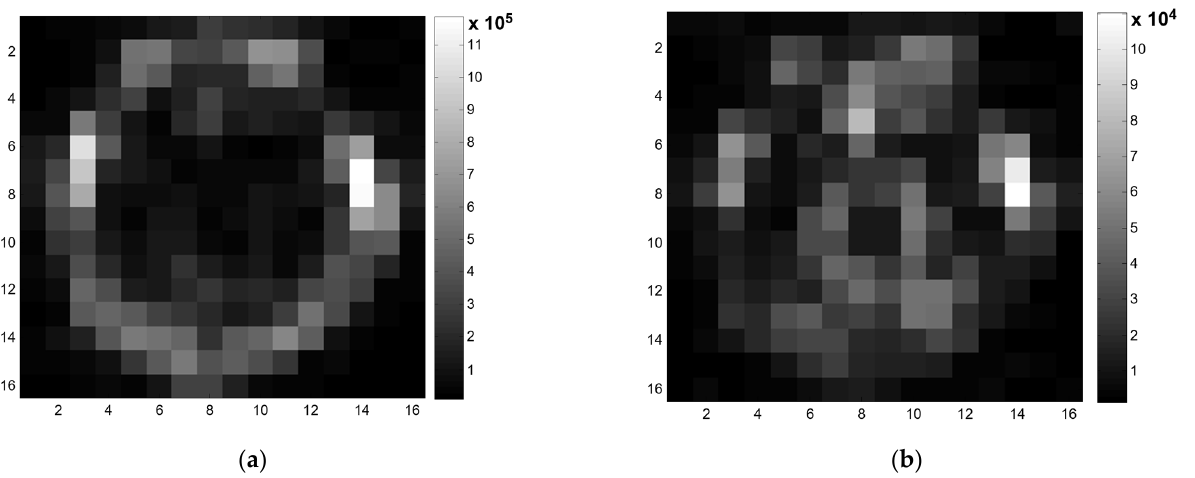
Figure 4. Comparing the MRSI result images before and after differential filtering. For each voxel, the absolute maximum intensity of the spectral signal was mapped: ( a ) the MRSI mapping image before differential filtering; and ( b ) the MRSI mapping image after differential filtering. The scale and high intensity in the brain boundary from fat in Figure 4a were removed in Figure 4b after filtering, revealing signals in the brain area.